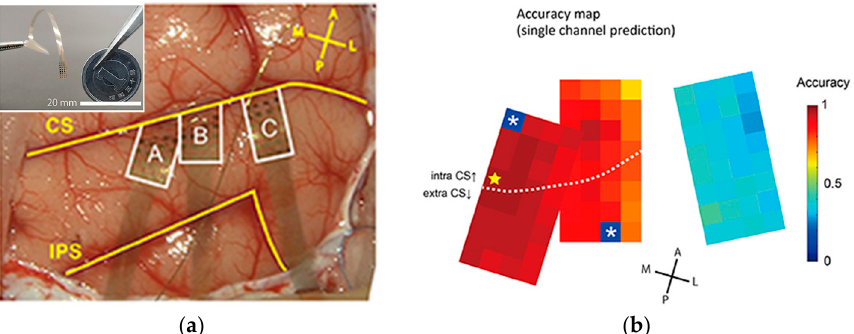
Figure 4. ( a ) Operative view of electrode placement. The three areas surrounded by the white line represent each electrode patch. Patches A and B were partially overlapped. Each patch was flexible and curved along the brain surface. A section of each patch was inserted into the central sulcus. The insert shows the photograph of one MEA; ( b ) Accuracy obtained from single-channel predictions are showed by pseudo colours. The yellow star indicates the channel with maximum accuracy. The two asterisks indicate broken channels. Reproduced with permission from [103], Frontiers Research